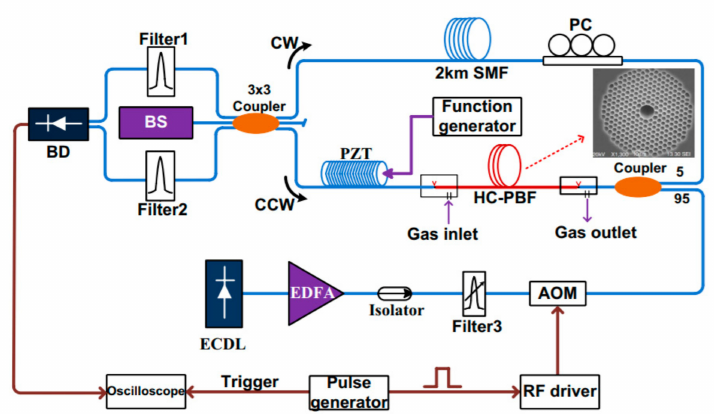
Figure 8. Pulsed PT gas sensor employing an HC-PCF as a gas cell. HC-PBF—hollow core photonic bandgapfiber, ECDL—external-cavitydiodelaserwithwavelengtharound1530.371nm, EDFA—erbium doped fiber amplifier, AOM—acoustic-optic modulator, BD—balanced detector, BS—broadband source, PC—polarization controller. Reprinted with permission from